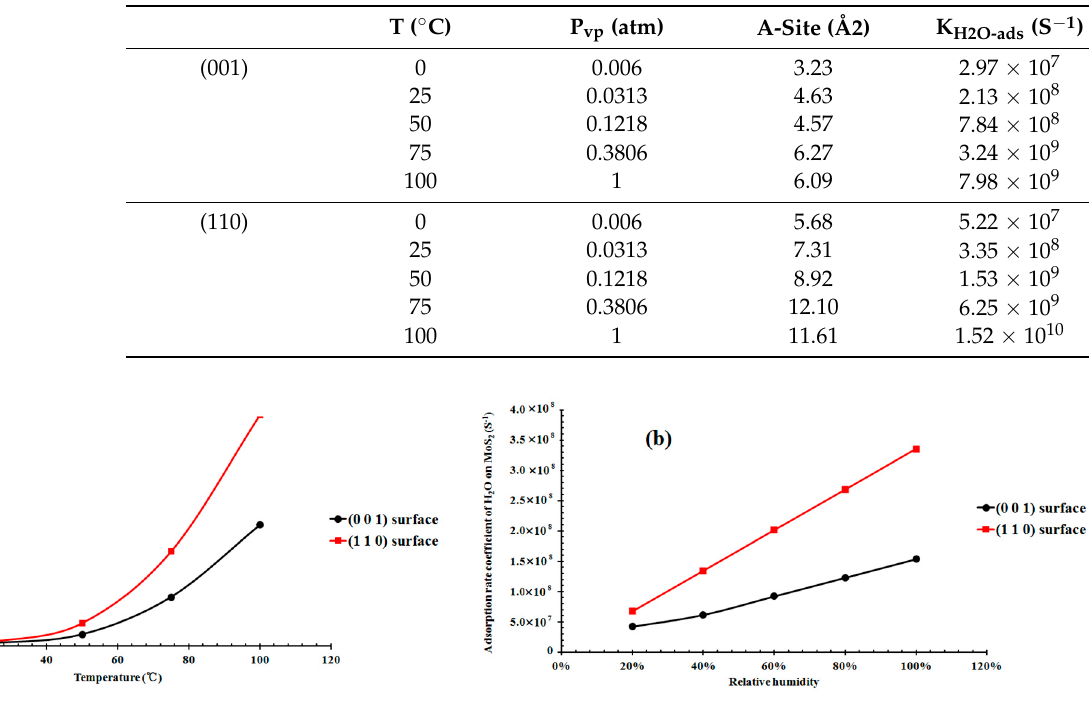
Figure 10. Adsorption rate coefficient of water molecules on molybdenite as a function of tempera- ture ( a ) and relative humidity ( b ). ( a ) and relative humidity ( b